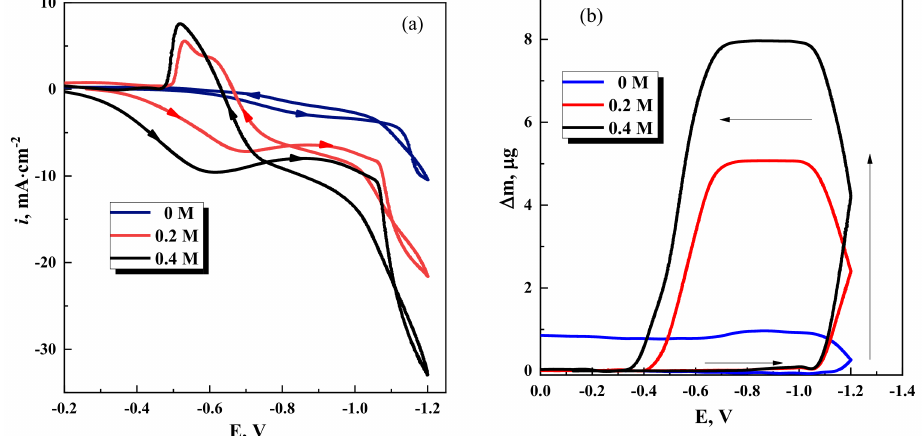
Figure 5. Cyclic voltammograms ( a ) and microgravimetry scans ( b ) obtained on Pt at various Na 2 WO 4 concentrations in the solution. Potential scan rate 20 mV/s; arrows indicate the direction of potential